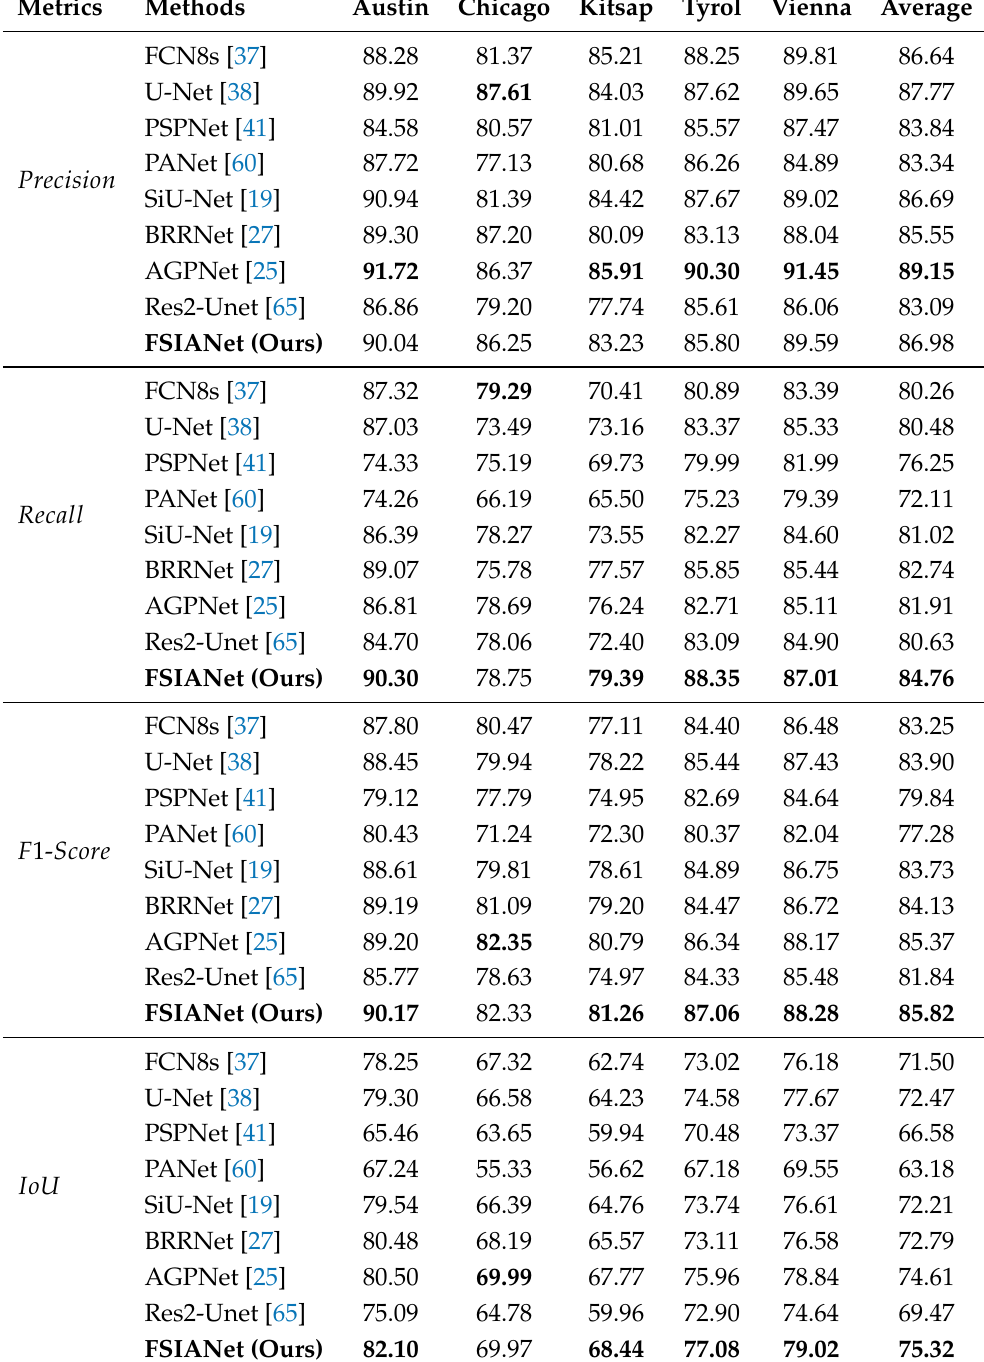
Table 3. Quantitative results on Precision , Recall , F 1- Score , and IoU (in %) of different methods on the Inria Aerial Image Dataset. The best results are shown in